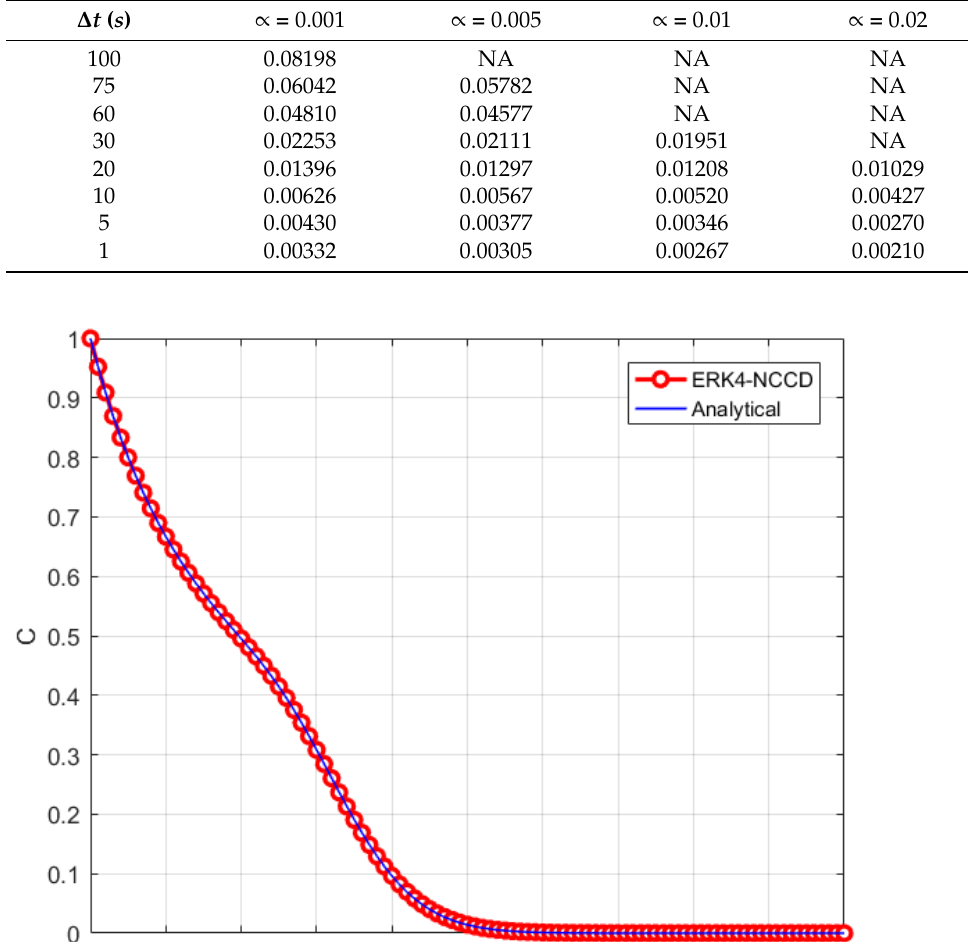
Table 6. 𝐿 ∞ norm errors of the ERK4-NCCD scheme for 𝑚 = 0.1 s −1 with different time steps ∆𝑡 and ∝ values at 𝑡 = 3000 s . NA indicates that the solution did not converged. Table 6. L ∞ norm errors of the ERK4-NCCD scheme for m = 0.1 s − 1 with different time steps ∆ t and ∝ values at t = 3000 s. NA indicates that the solution did not converged.